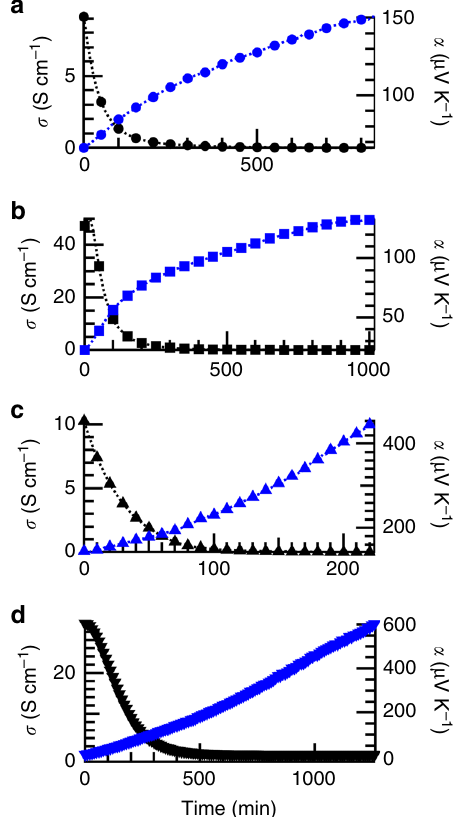
Fig. 2 Conductivity and Seebeck coef fi cient of polymers measured during de-doping. Conductivity (black markers, left axes) and Seebeck coef fi cient (blue markers, right axes) for a poly(3-hexylthiophene) (P3HT) doped at 25 °C (circles), b P3HT doped at 75 °C (squares), c poly[2,5-bis(2- octyldodecyl)pyrrolo[3,4-c]pyrrole-1,4(2H,5H)-dione-3,6-diyl)-alt- (2,2 ′ ;5 ′ ,2 ′′ ;5 ′′ ,2 ′′′ -quaterthiophen-5,5 ′′′ -diyl)] (PDPP4T) doped at 25 °C (up triangles), and d PDPP4T doped at 75 °C (down triangles). One of every fi ve data points collected is plotted along a dashed line as a